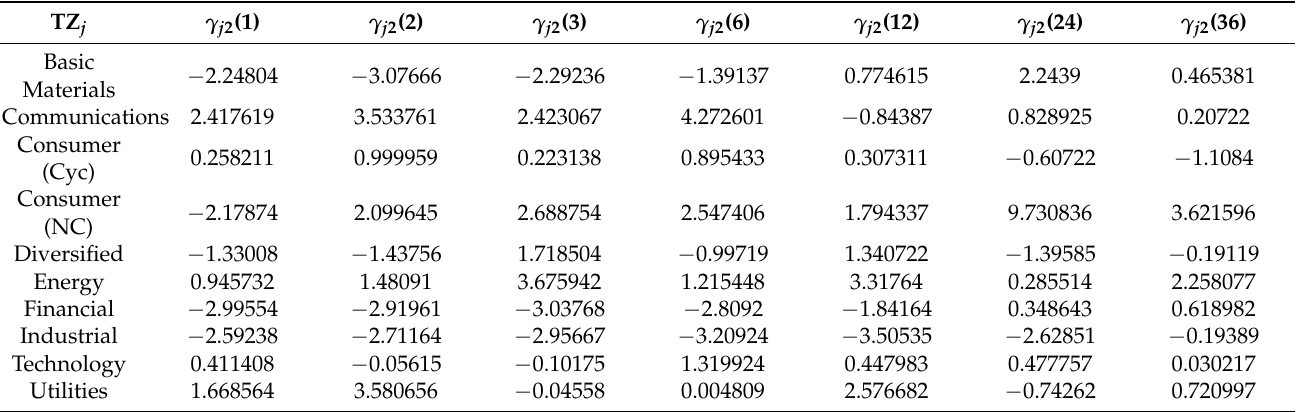
Table 3. Maximum pseudo-likelihood estimates for γ j 2 (l) .